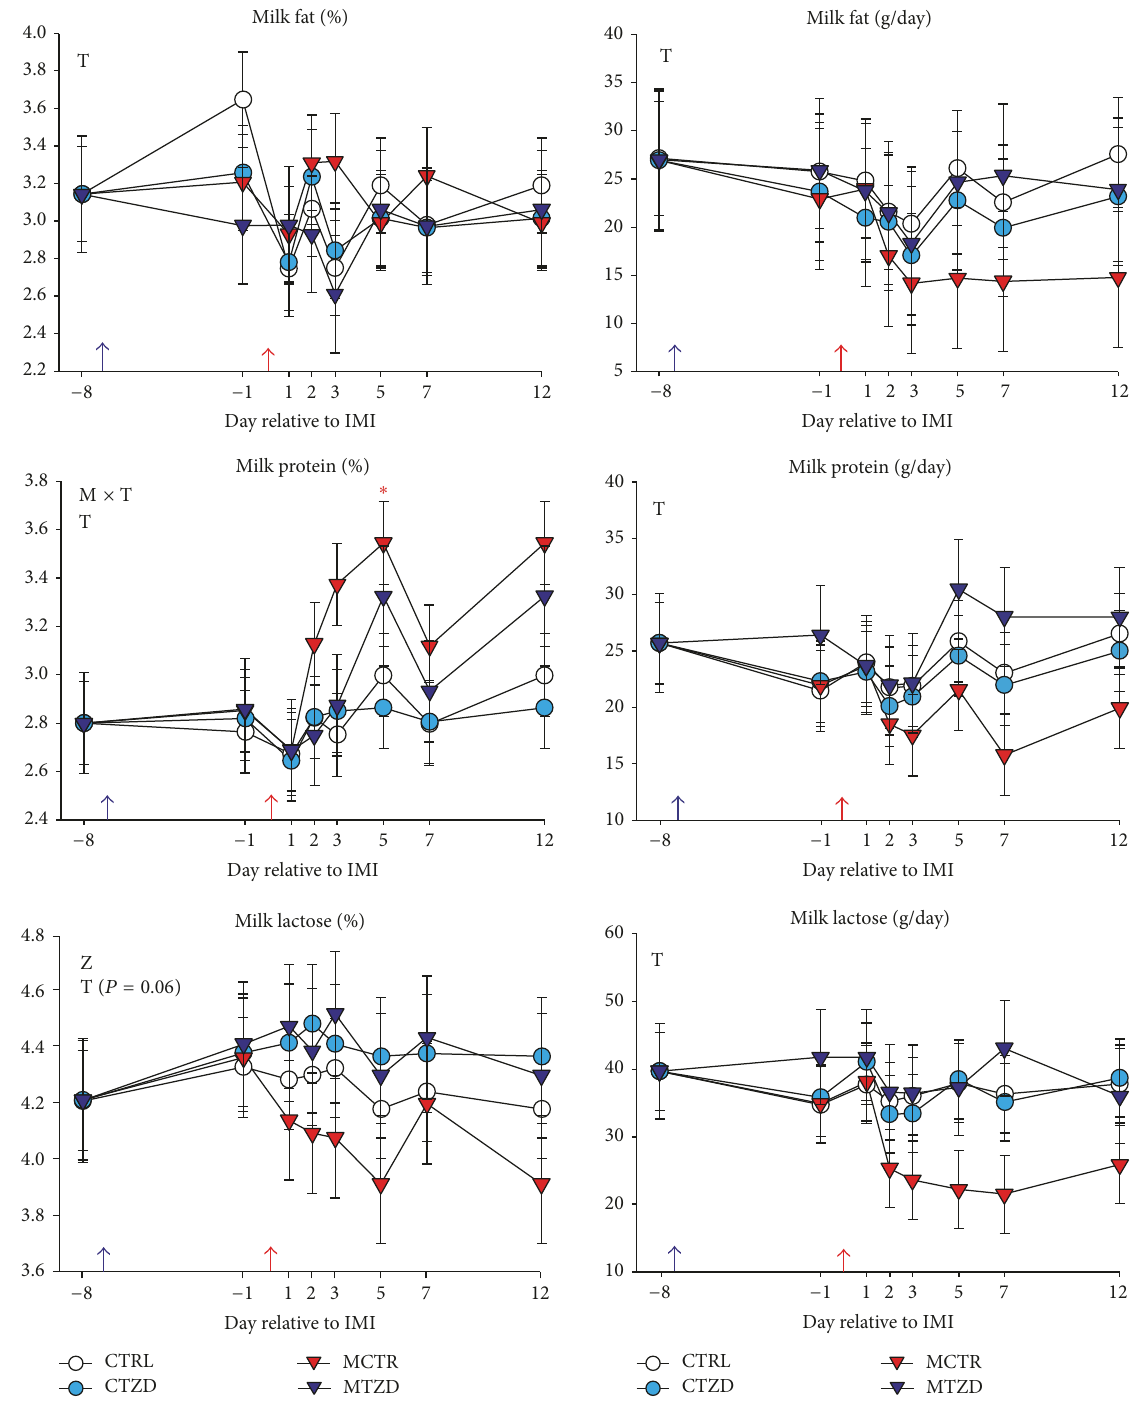
Figure 4: Milk components from − 8 to 12d relative to intramammary infusion of Strep. uberis (M) or saline in goats receiving daily intrajugular injection of 2,4-thiazolidinedione (TZD) or saline (CTR). Significant ( 𝑃 ≤ 0.05 ) effects and interactions are indicated in the graph (mastitis: M, time: T, and TZD: Z). The 𝑃 value for tendency is reported. Significant effect of M × T is denoted with red